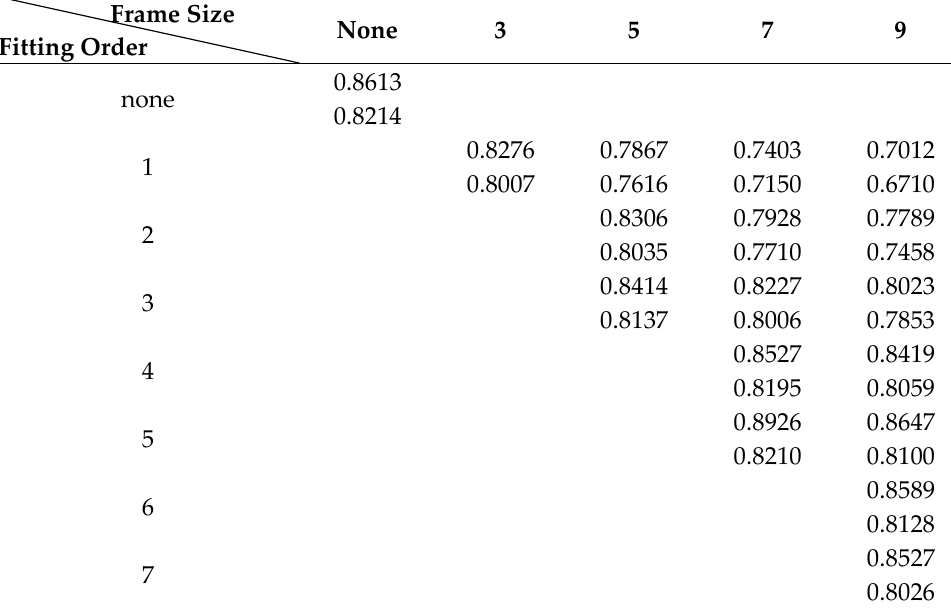
Figure 2. Reflective spectral curves. ( a ) Raw spectrum; ( b ) spectrum after SNV pretreating. Table 2. Correlation coefficients of Cs and Vs with different S-G parameters. Table 2. Correlation coefficients of Cs and Vs with different S-G parameters.